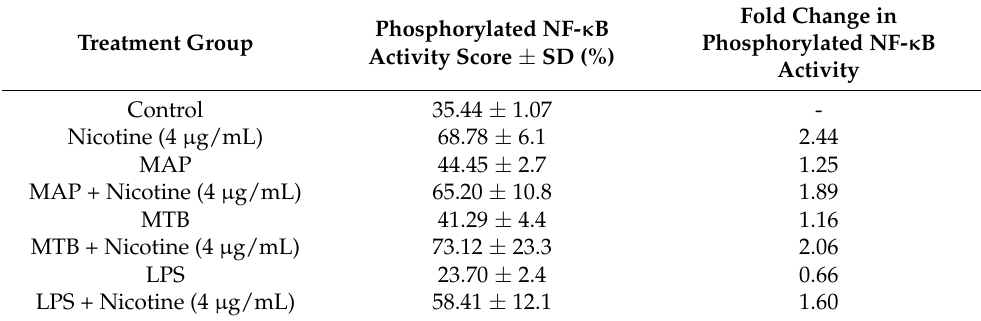
Table 2. Activation Score of Phosphorylated NF- κ B p100/p52 (%).